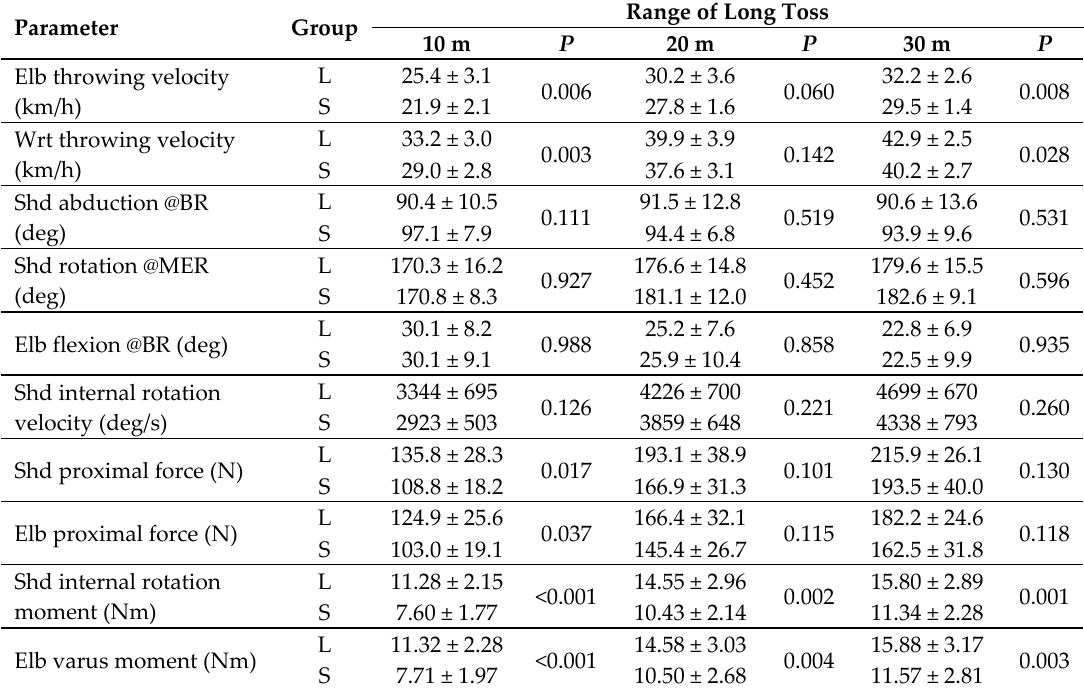
Table 4. Difference in throwing between the two groups in each range of long